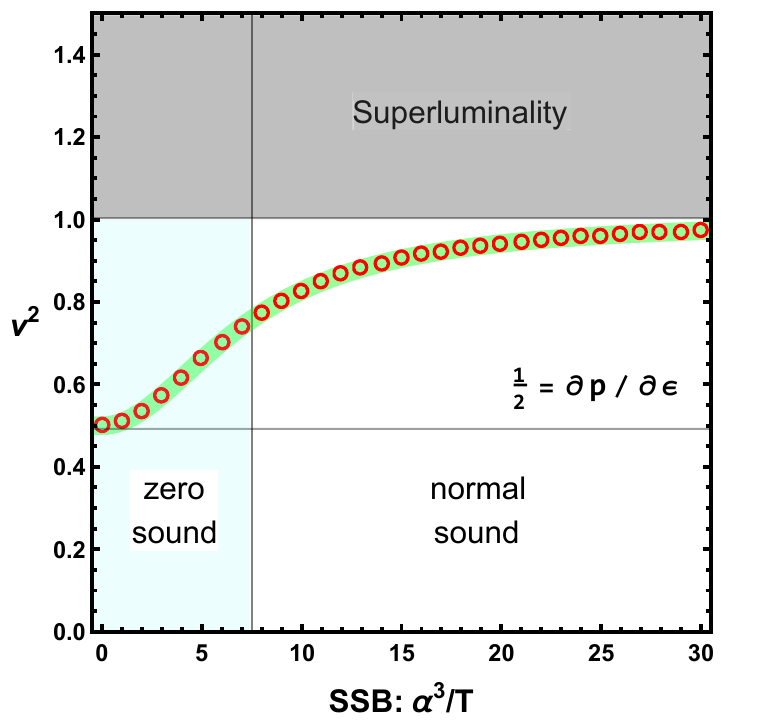
Figure 11 . The speed of longitudinal sound as a function of the dimensionless SSB scale α 3 /T . The red dots are numerical data extracted using formulae (6.6), (6.7) and (6.8). The superluminal region v 2 > 1 is displayed in the phase diagram with shaded color. The crossover between two L 7 . 5. At small SSB the speed of sound is close to regimes is clear and it happens around α 3 /T ∼ = ∂p/∂(cid:23) = 1 / 2. At higher value of the SSB parameter the speed is mainly the zero sound limit v 2 0 governed by the elastic properties of the material; we call that “normal sound”. For simplicity, this plot is done at µ =